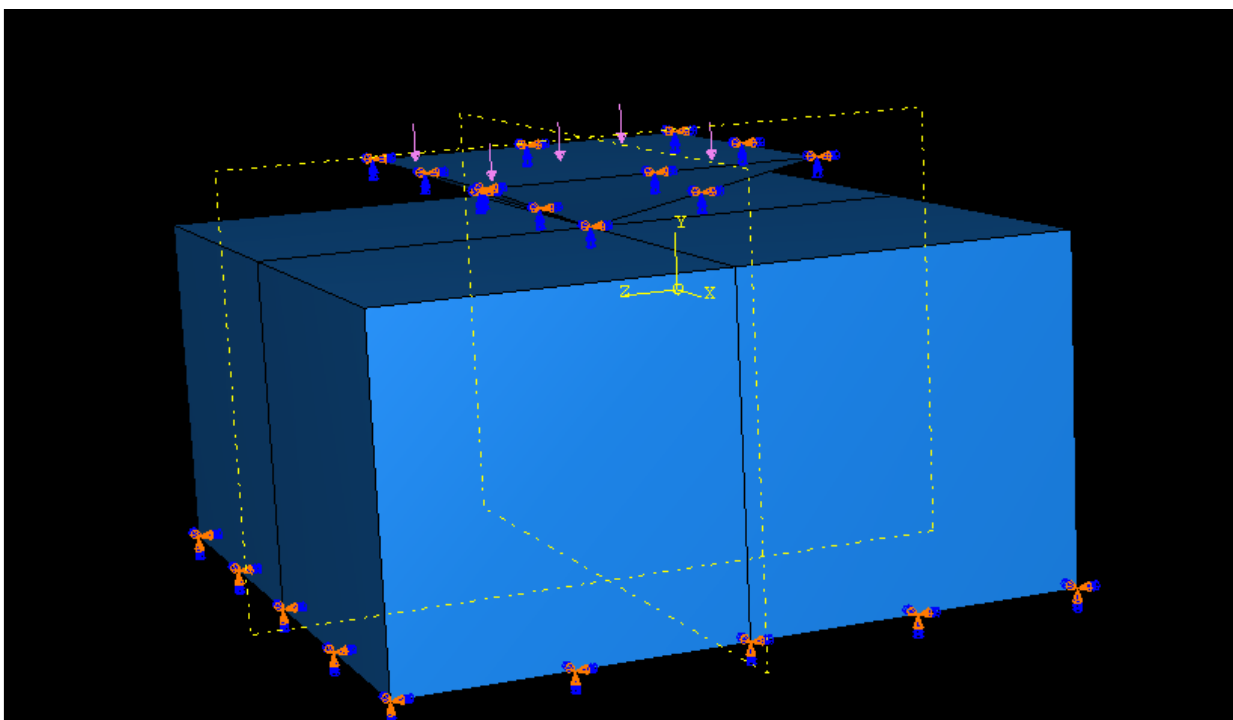
Fig. 9. (Color online) Boundary condition for Vickers